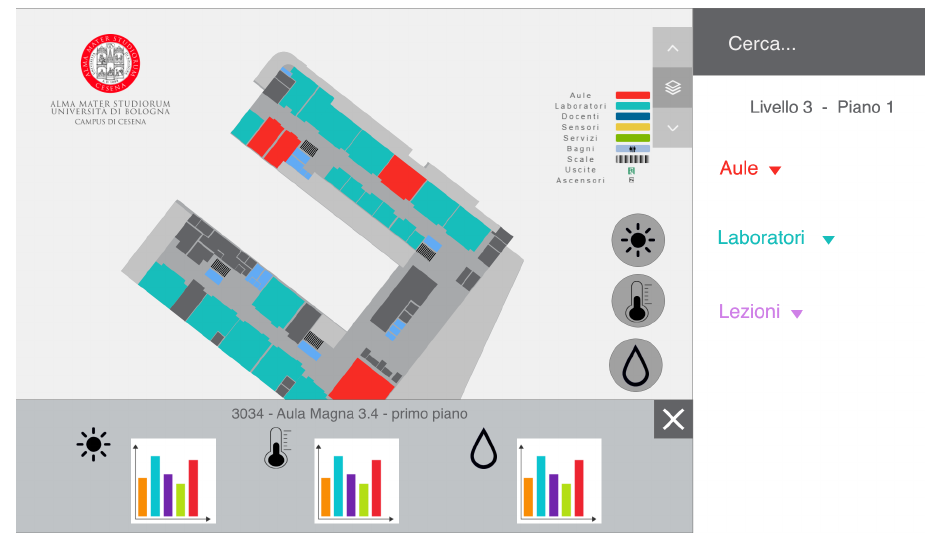
Figure 5. When a space is selected, the graphs for all the data will be